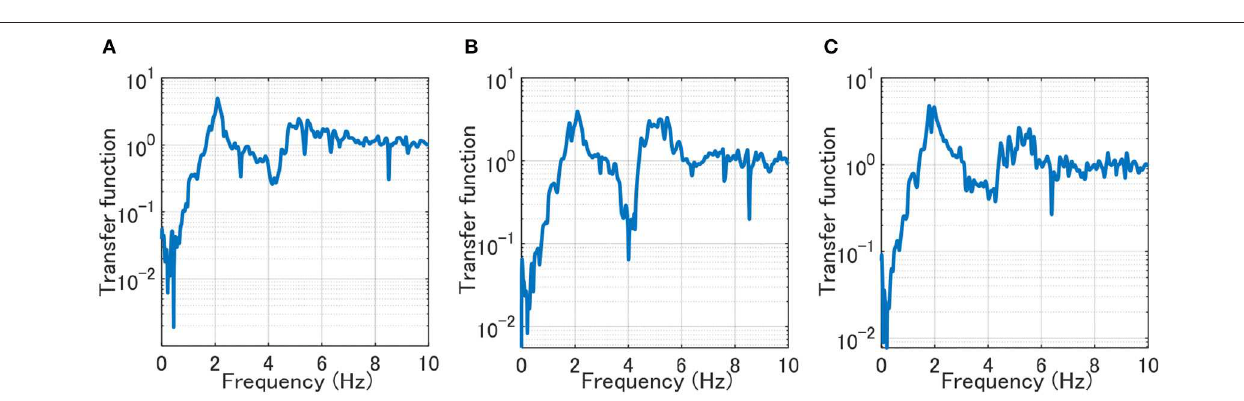
FIGURE 6 | Reference distribution of transfer function. (A) Vertical frame y1_1F. (B) Vertical frame y2_1F. (C) Vertical frame